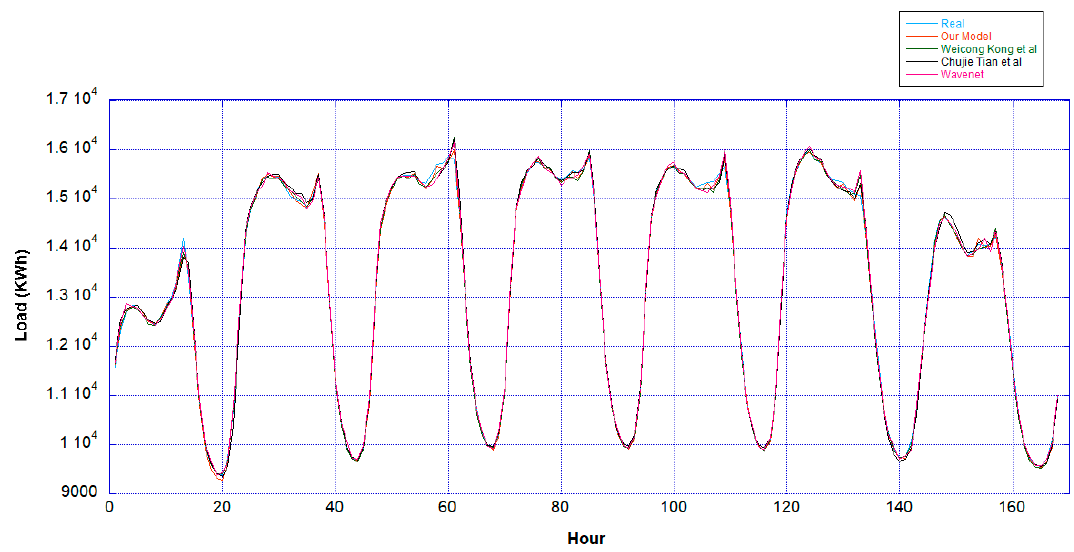
Figure 11. Forecasting result using ISO-NE dataset 1.